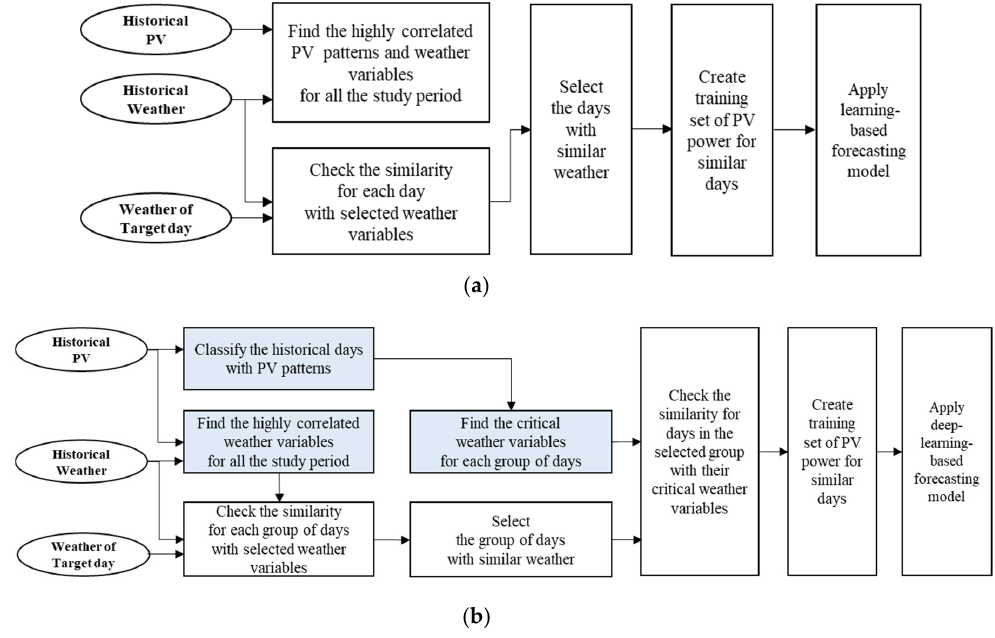
Figure 3. Overview of similar day detection strategies: ( a ) conventional method and ( b ) proposed method.